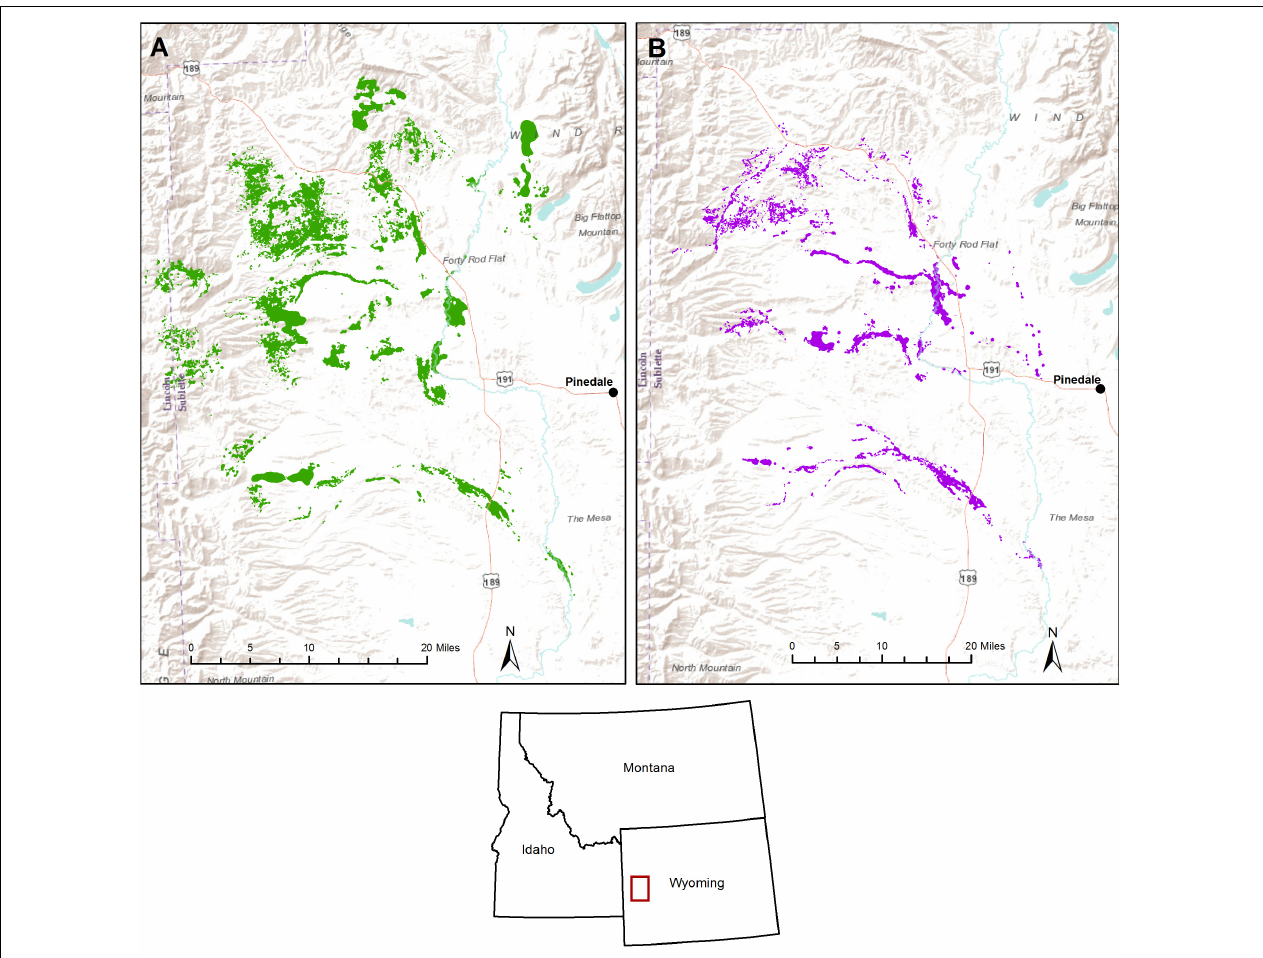
FIGURE 1 | Map of study area showing a sample ( n = 63) of seasonal home ranges of adult ( > 2.5 years), GPS-collared moose from 2012 and 2013, derived from dynamic Brownian bridge movement models for summer (A) and winter (B) in Sublette County of western Wyoming, United